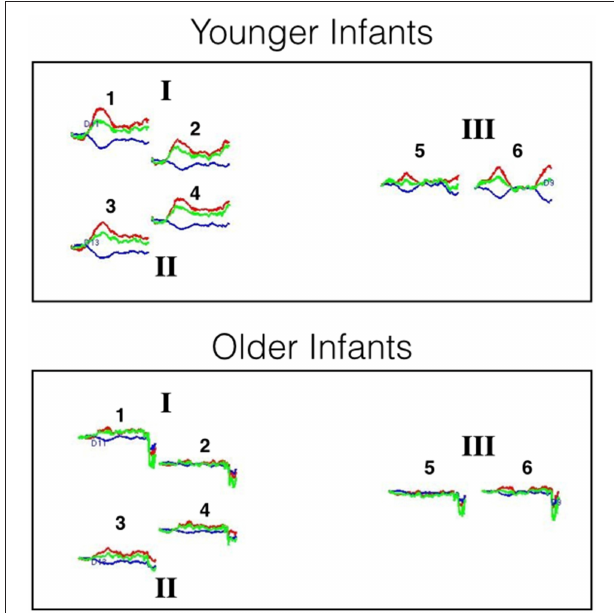
FIGURE 5 | Hemodynamic response curves for the younger and older infants of Experiment 2. The number above each plot refers to the channel number and the Roman numerals refer to areas of interest. All regions are thought to lie within the posterior temporal cortex. The plot shows the mean HbO (red lines), HbR (blue lines), and HbT (green lines) curves in µ M cm. Time is on the x-axis: the first black line on each plot denotes the onset of the 20s test trial and the second black line denotes the onset of the 10s baseline interval.